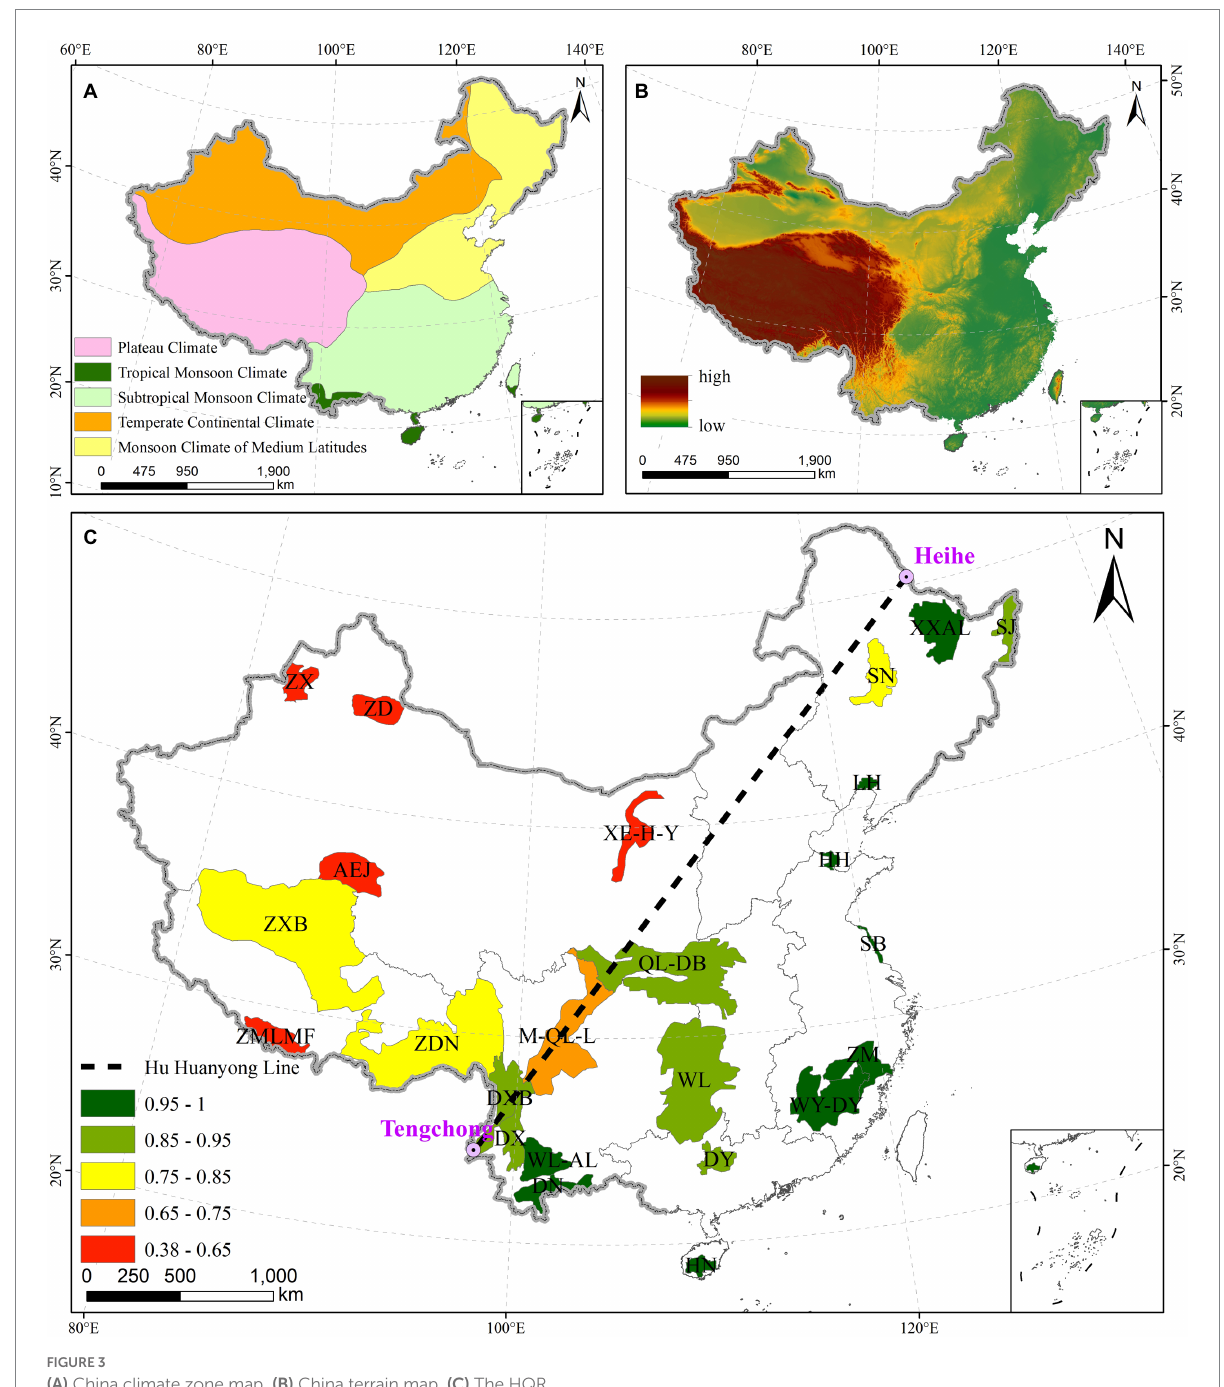
FIGURE 3 (A) China climate zone map. (B) China terrain map. (C) The